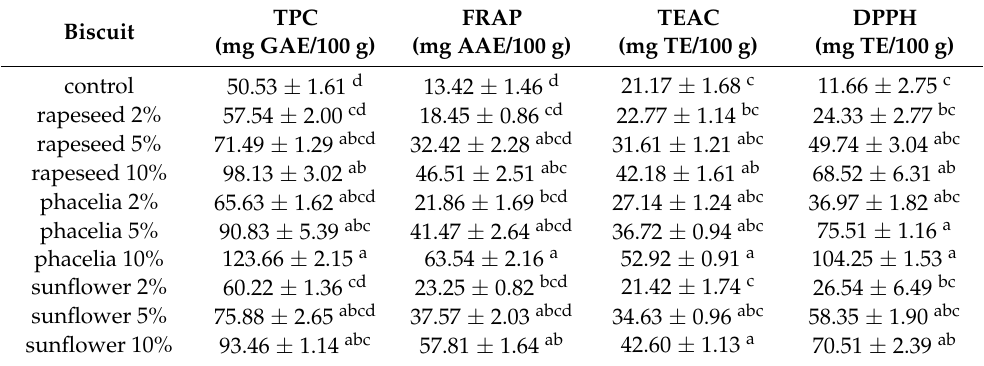
Table 3. Total phenolic content (TPC) and antioxidant capacity (FRAP, TEAC, DPPH) of pollen enriched